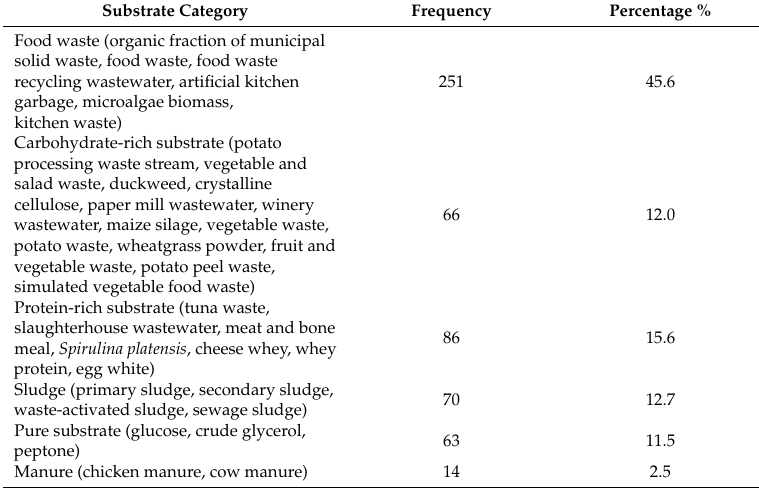
Table 2. Frequency (number of experiments) and percentage of substrate types, grouped by